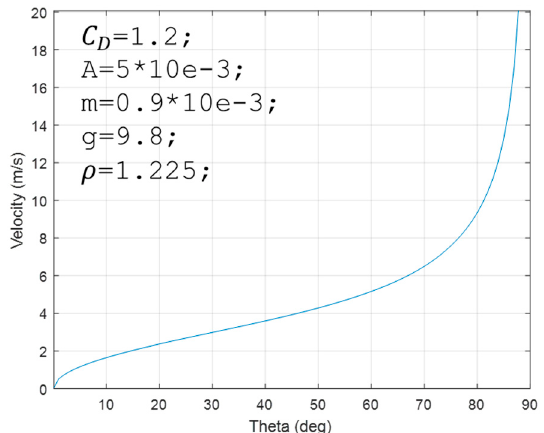
Figure 3. Air-Odo theoretical relationship between angle and velocity.